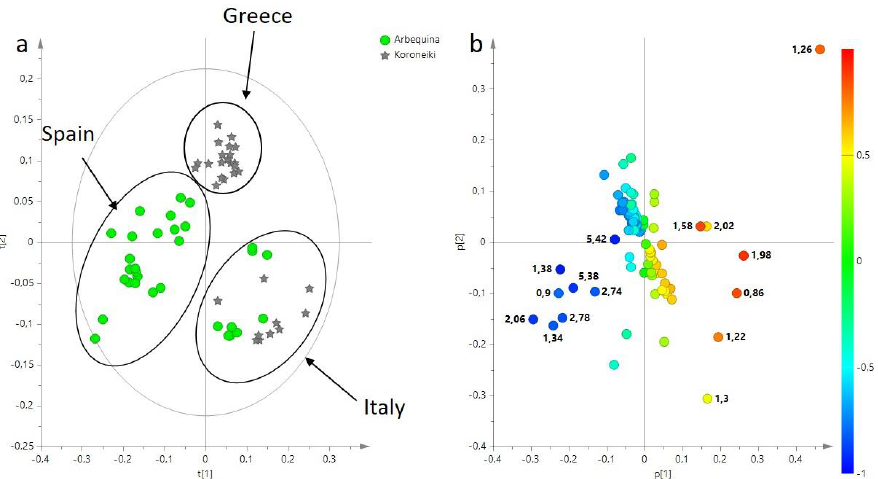
Figure 1. ( a ) t[1]/t[2] PCA score plot performed on major components (BUCKET-1) for Arbequina and Koroneiki EVOOs samples obtained from Spain, Greece, and Italy, ( b ) PCA loading plot, colored according to the correlation-scaled loading vector (p(corr)). The variables indicated the chemical shift value (ppm) in the 1 H NMR spectrum.